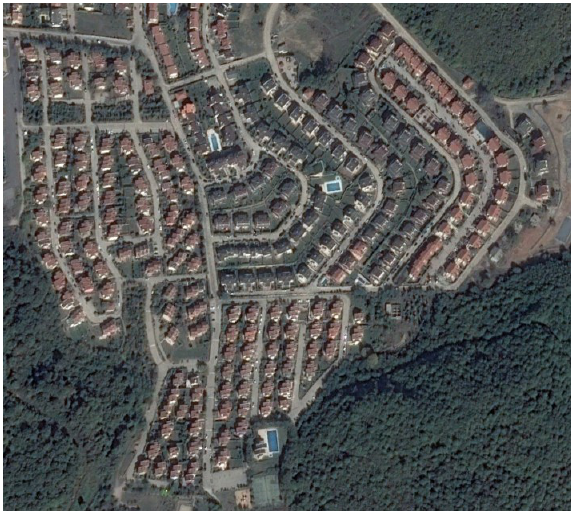
Figure 4. Study area in Istanbul.